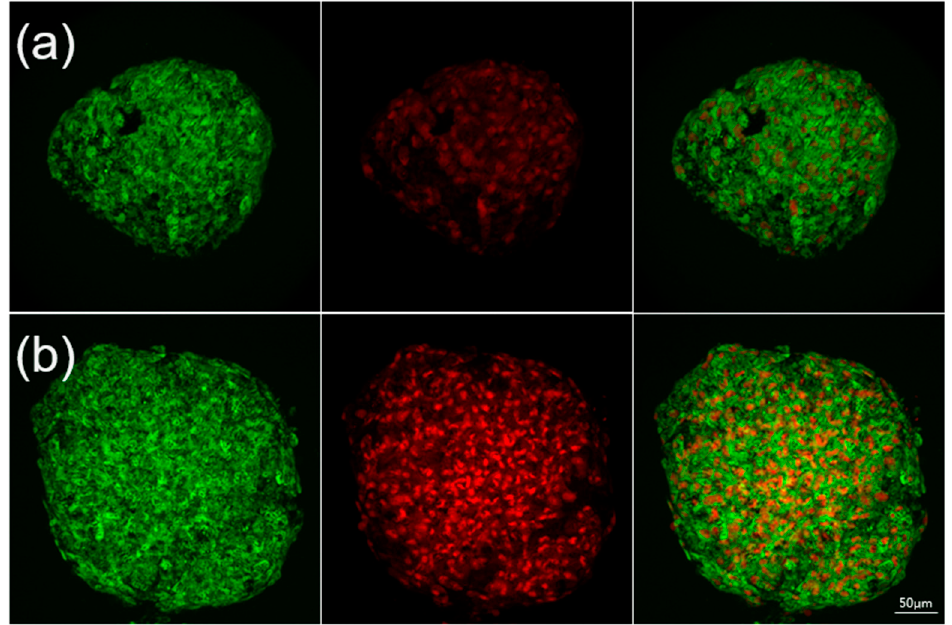
Figure 7. Live and dead stain of the spheroids were cultured in microfluidic-based hanging-drop chip: ( a ) day 3, and ( b ) day ( a ) day 3, and ( b ) day 7.